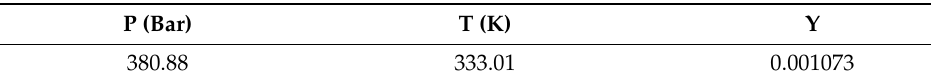
Table 3. Optimal values (GBRT Model).